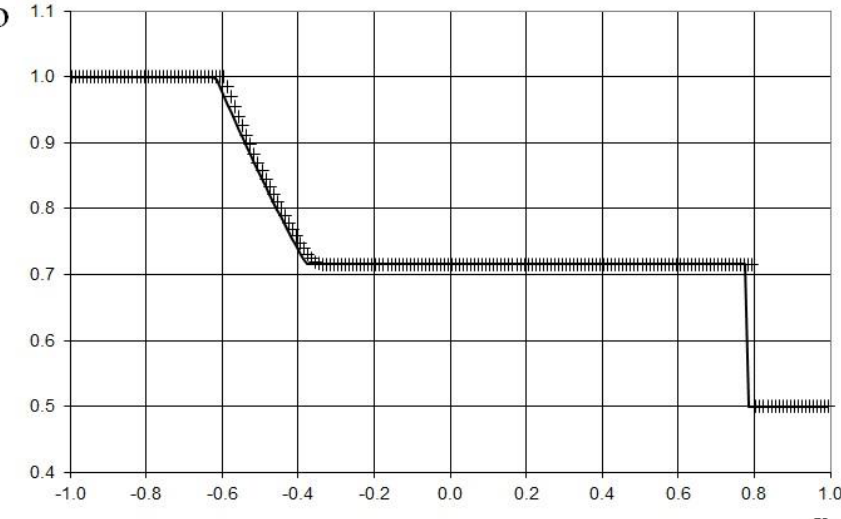
Figure 5. Density plot for the shock-tube problem (46) for the adiabatic gas dynamics equations: the exact solution (line), and the present method (cross).